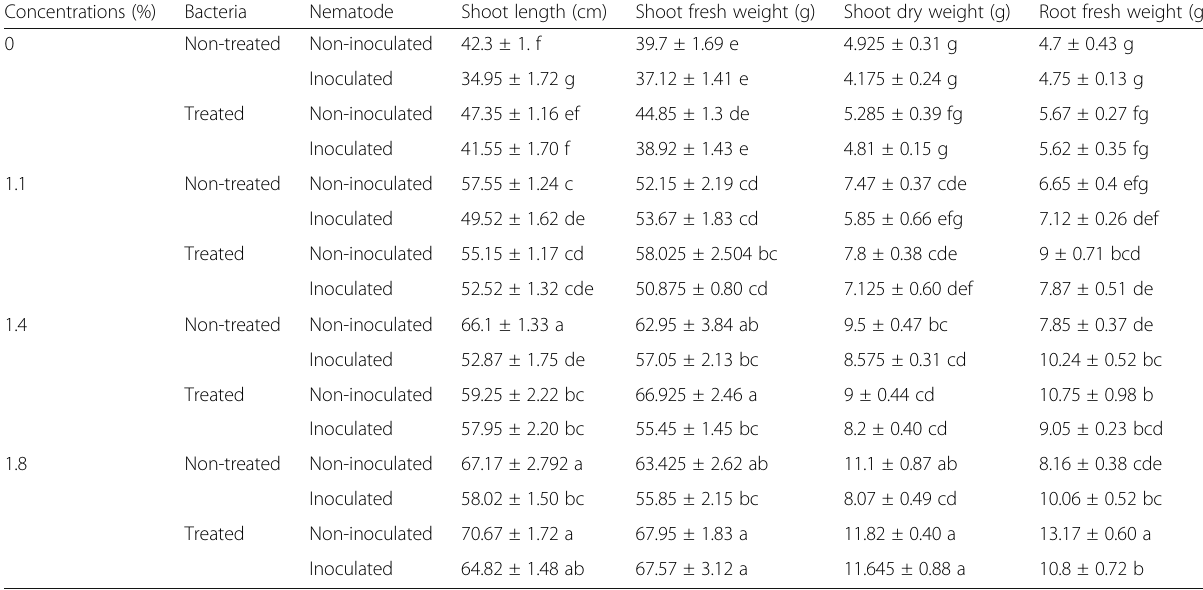
Table 4 Mean plant growth indices of tomato, inoculated or non-inoculated with Meloidogyne javanica along with Pseudomonas fluorescens CHA0 and different concentrations of Datura stramonium treated in trials I and II Concentrations (%)